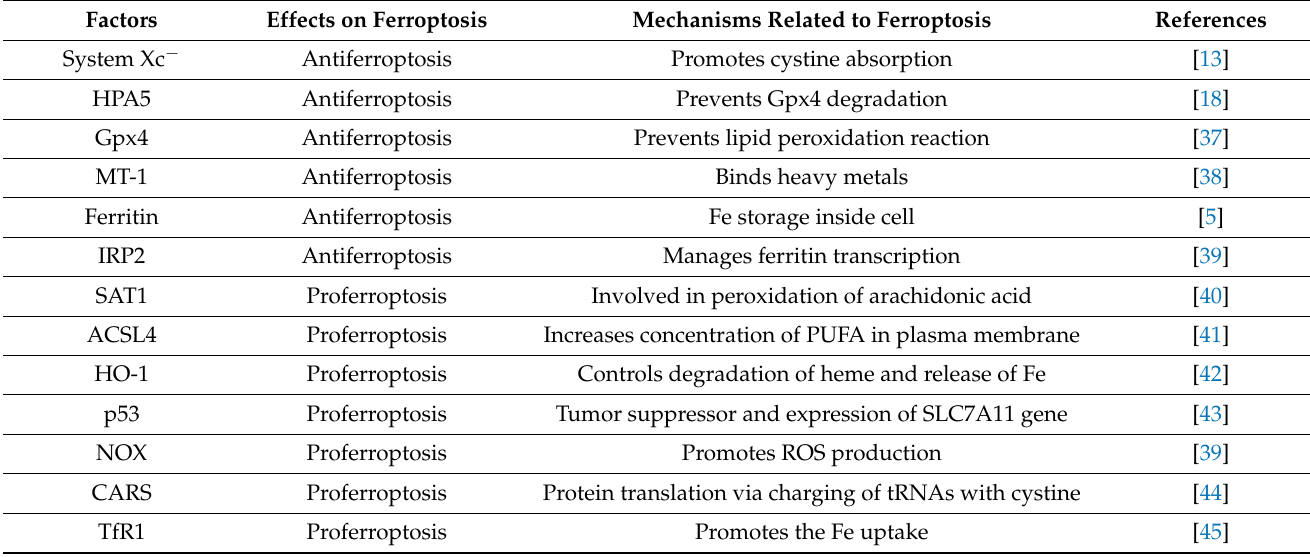
Table 1. The effects of various factors and mechanisms involved in